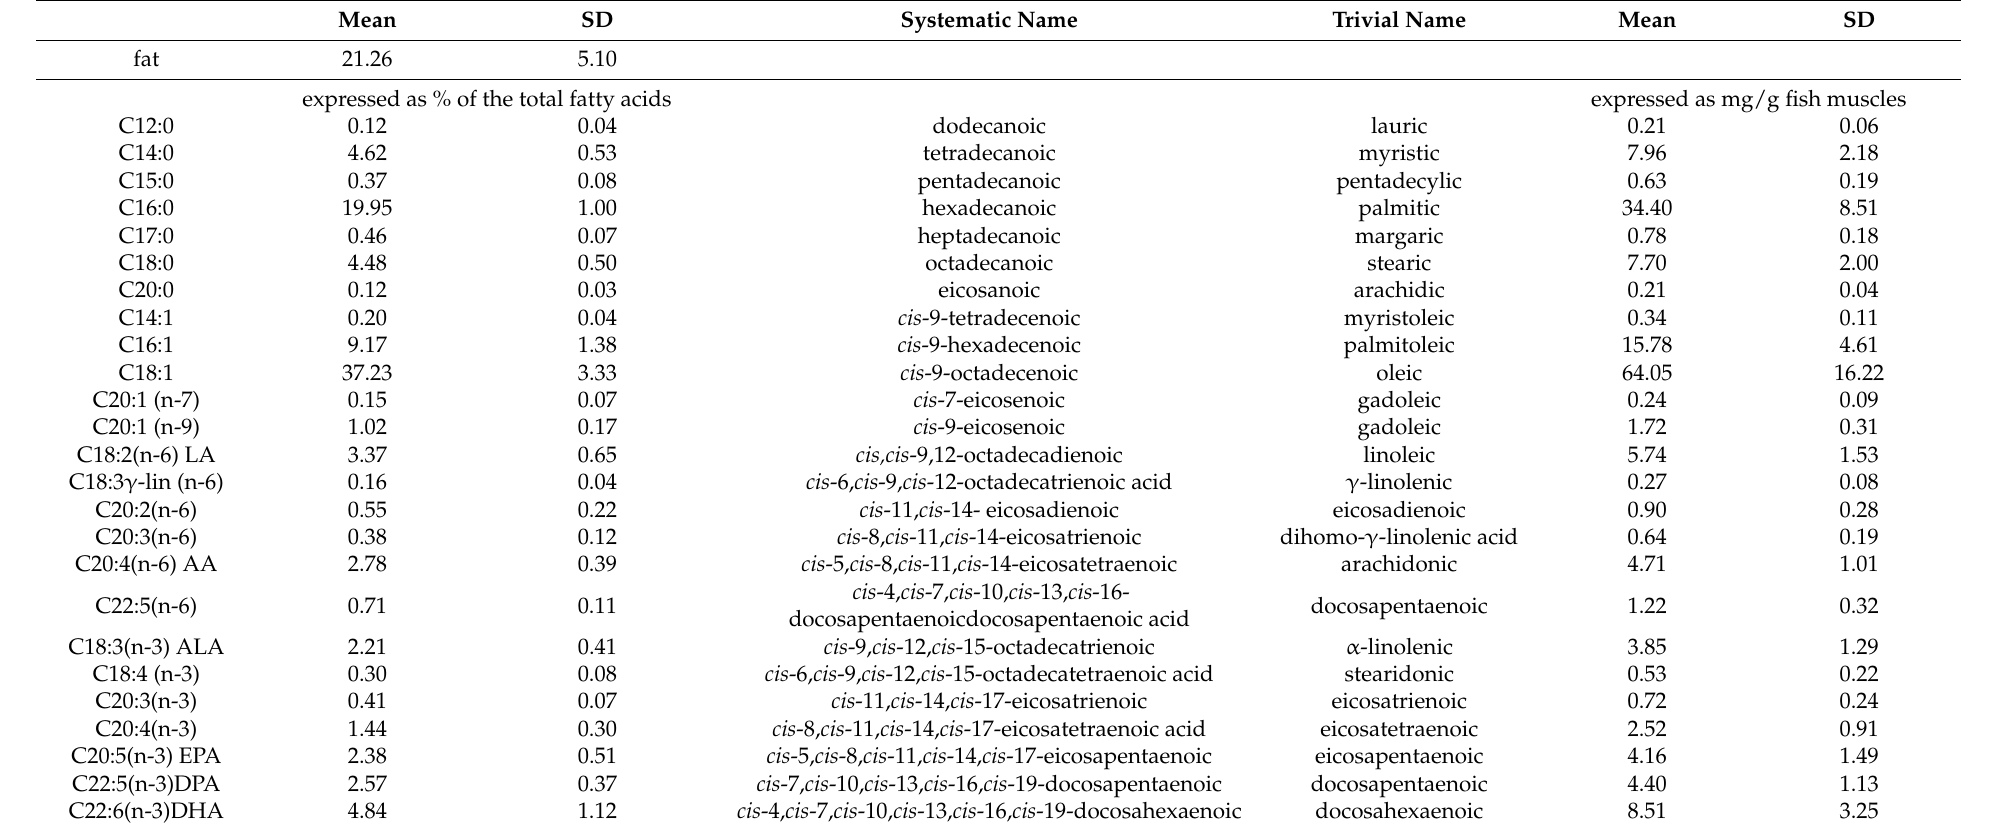
Table 3. Lipid content (%) and fatty acids composition in muscles of the European eel ( Anguilla anguilla L.). Mean SD Systematic Name Trivial